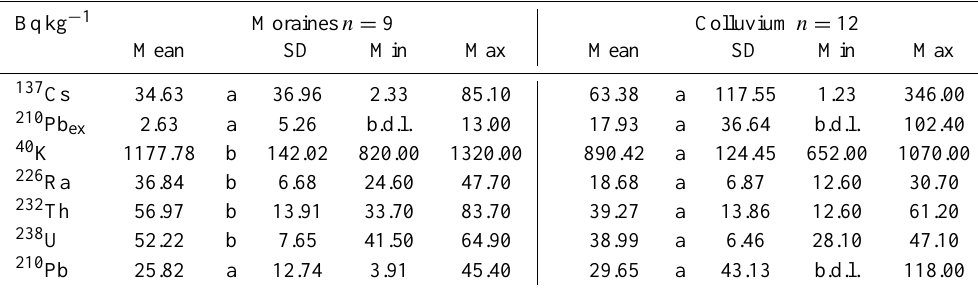
Table 7. Summary statistics of radionuclide contents in the samples of the soil profiles of the moraines and colluviums. Different letters indicate significant differences at the p level 0.05 between moraines and colluvium soils.